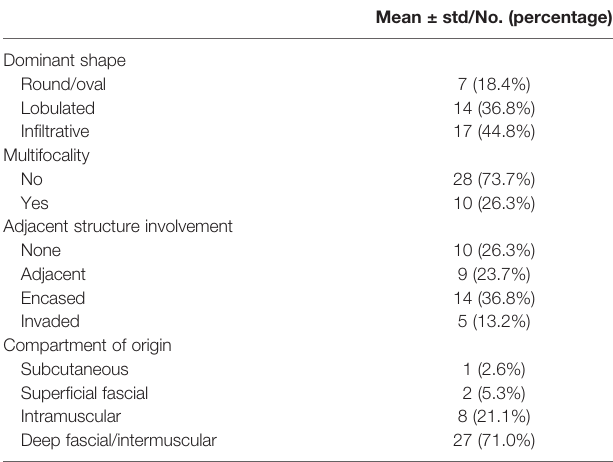
TABLE 3 | Imaging characteristics.